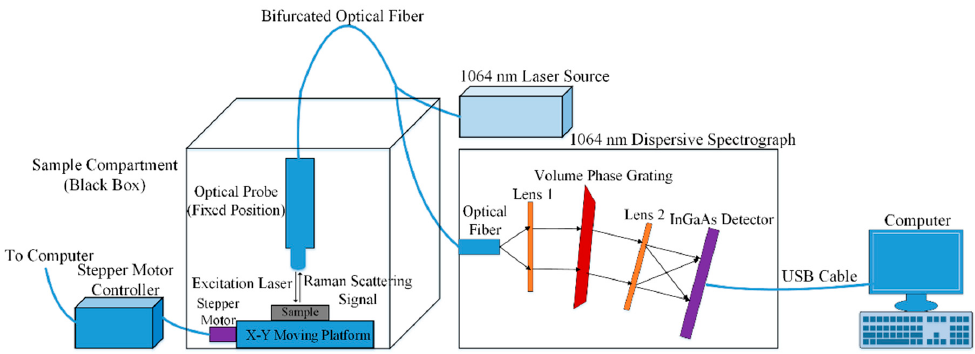
Figure 1. Schematic of 1064 nm dispersive Raman spectral imaging system.